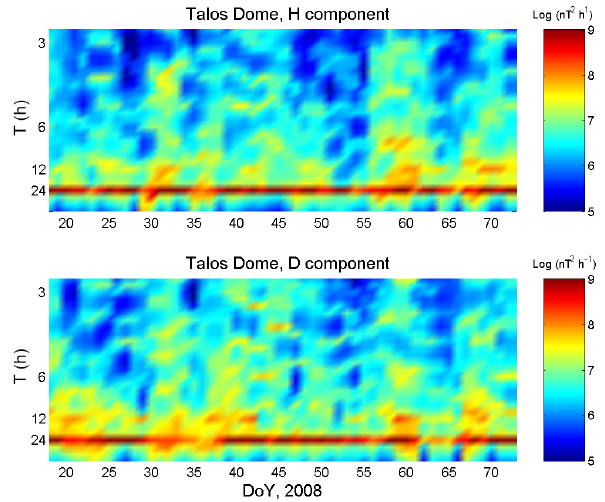
Figure 3. Dynamic spectra from hourly data at